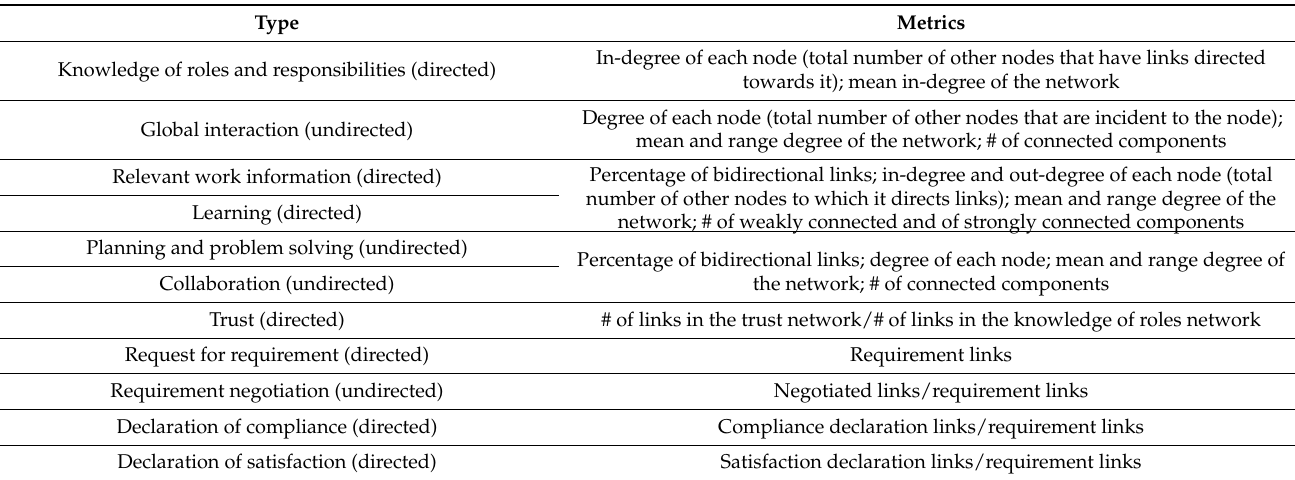
Table 6. Metrics for each network. Adapted from